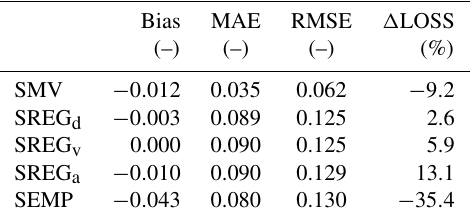
Table 4. Performance of the uni- and multivariable models devel- oped based on local data in estimating relative damages and overall monetary loss to buildings (see Eqs. 4, 5, 6 and 7; the observed over- all monetary loss is equal to EUR15.2million). Models are ranked according to RMSE values, from the lowest to the largest. Corre- sponding results for literature models are reported in Table 5.